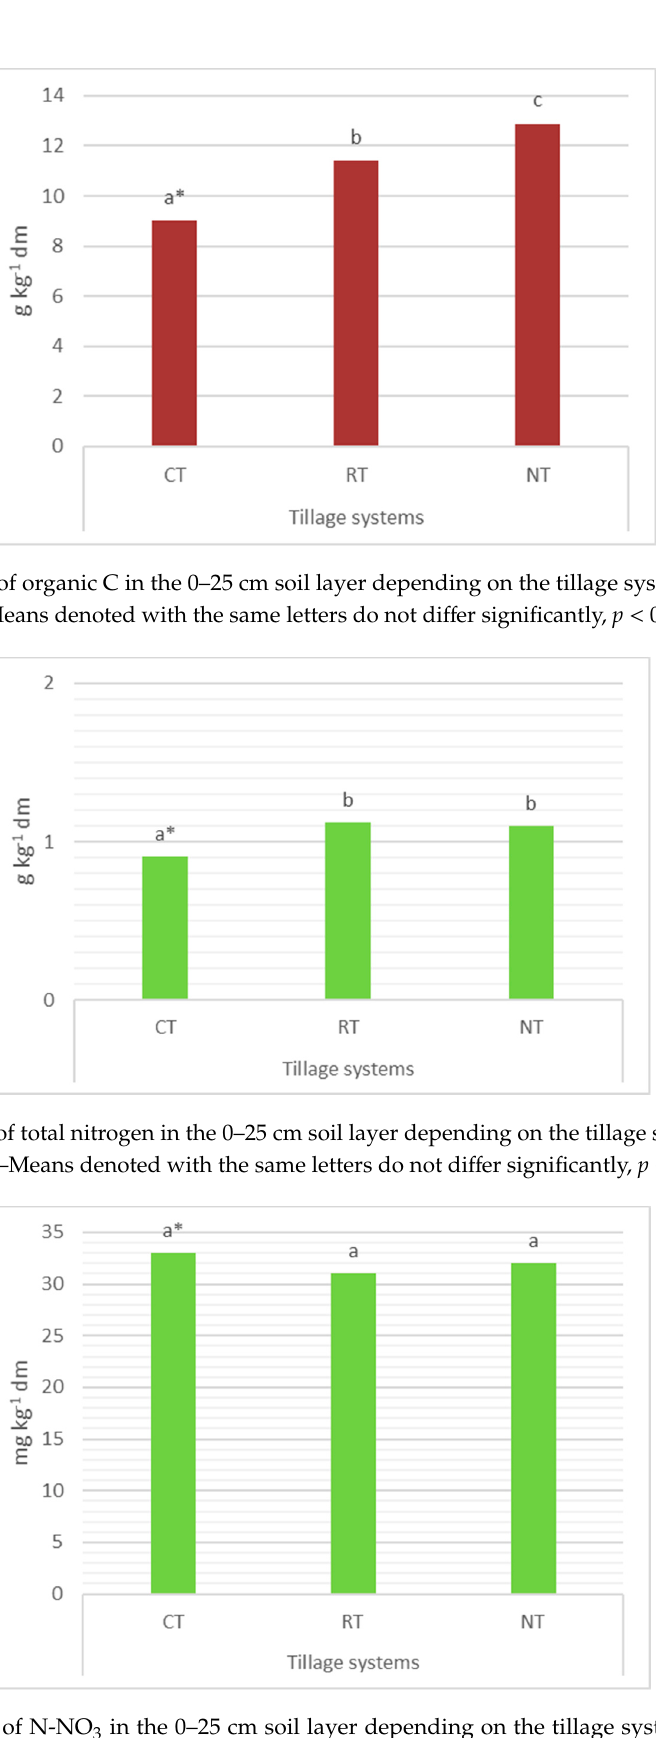
Figure 7. Content of N-NH 4 in the 0–25 cm soil layer depending on the tillage system (average of 2014–2016). * a—Means denoted with the same letters do not differ significantly, p < 0.05. Figure 8. Content of phosphorus (P) in the 0–25 cm soil layer depending on the tillage system (average of 2014–2016). * a—Means denoted with the same letters do not differ significantly, p < 0.05.